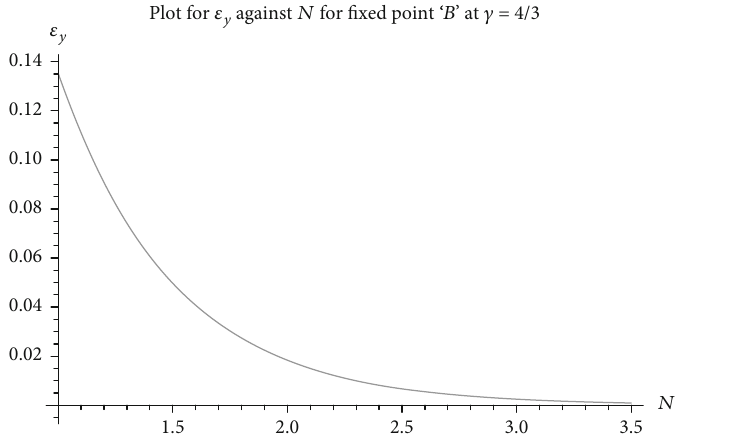
) against N at λ = 0 : 5 for fi xed point B . x